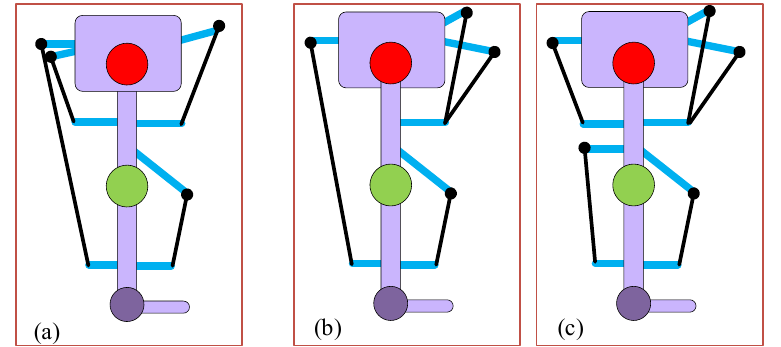
Figure 12. Cable routings: ( a ) The 4-cable case (II) routing, ( b ) The 4-cable case (III)- c routing, and ( c ) The 5-cable routing.